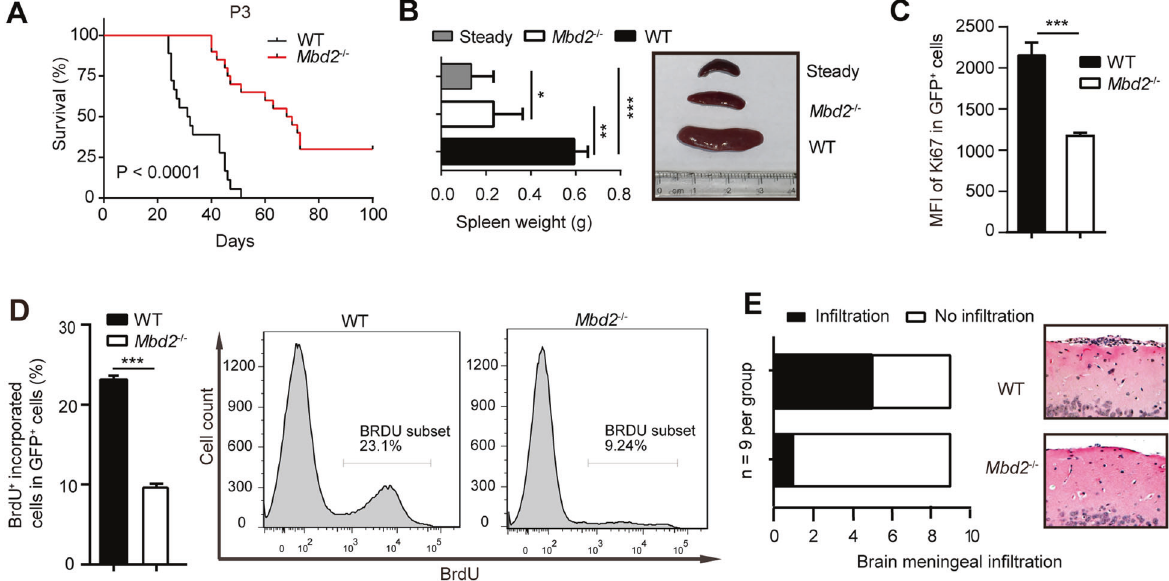
Fig. 2 Knockout of MBD2 attenuates AML proliferation and in fi ltration. A Kaplan – Meier survival curves for P3 mice ( n ≥ 10 per group, two independent experiments). B Weights of the spleens (left) and a representative picture of spleens (right) obtained from leukemic mice are shown. ‘ Steady ’ indicates the spleen from a corresponding healthy mouse. Error bars, s.d. C Flow cytometric determination of Ki67 proliferation indexes reported as the mean fl uorescence intensities (MFIs). Error bars, s.d. D BrdU + cells among the total GFP + leukemia cells (left panel) and representative histograms (right panel) of Mbd2 − / − versus WT leukemic mice. The data are shown as the mean percentage ± s. d., n = 5 per group, 2 independent experiments. E The numbers of WT or Mbd2 − / − leukemic mice ( n = 9 per group, two independent experiments) with meningeal leukemia (left panel). Representative hematoxylin and eosin staining (HE, right panel) images (×100) of in fi ltration of AML cells in the brain meningeal spaces of WT and Mbd2 − / − leukemic mice. Scale bar, 10 μ m. * P < 0.05, ** P < 0.005, and *** P <